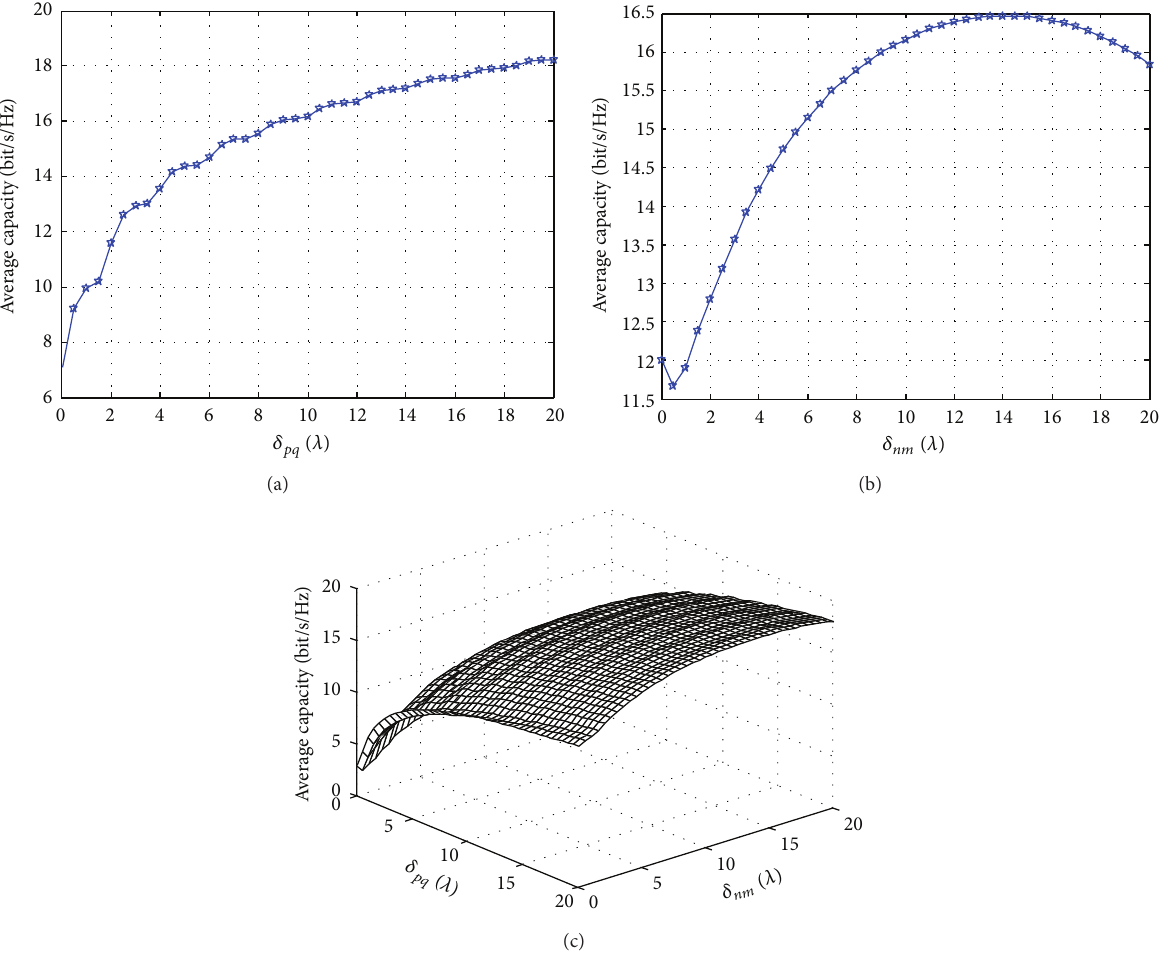
Figure 4: Influence of antenna interval on average channel capacity. (a) Transmitting antenna; (b) receiving antenna; (c) three-dimensional